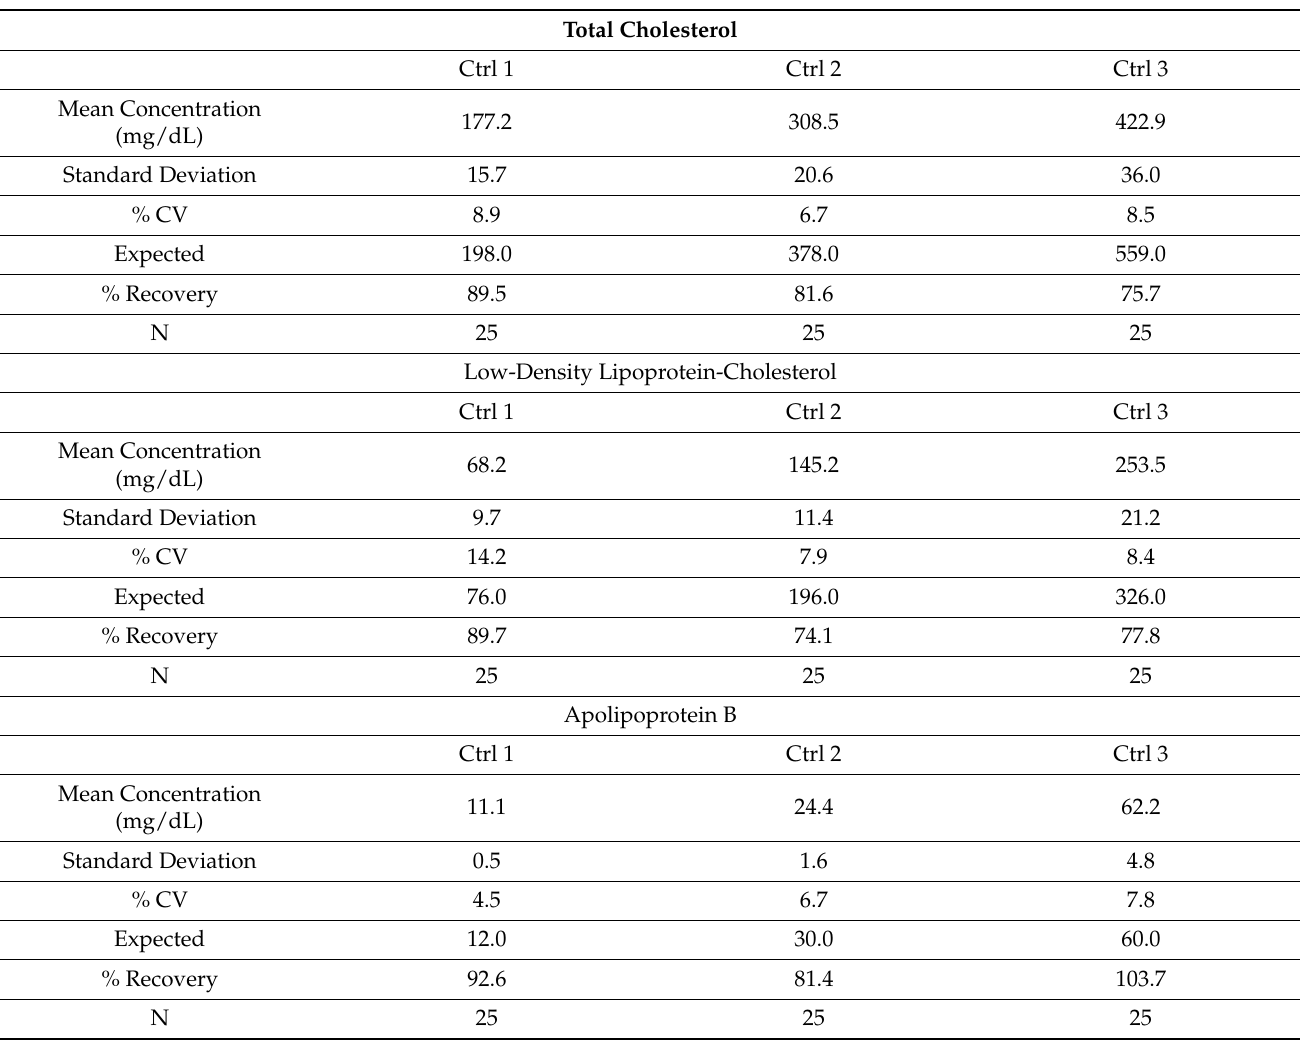
Table 1. Assay precision and recovery of total cholesterol, low-density lipoprotein-cholesterol, and apolipoprotein B from dried blood spot controls. CV, coefficient of variation; N, total number of evaluations. Total Cholesterol Ctrl 2 Ctrl